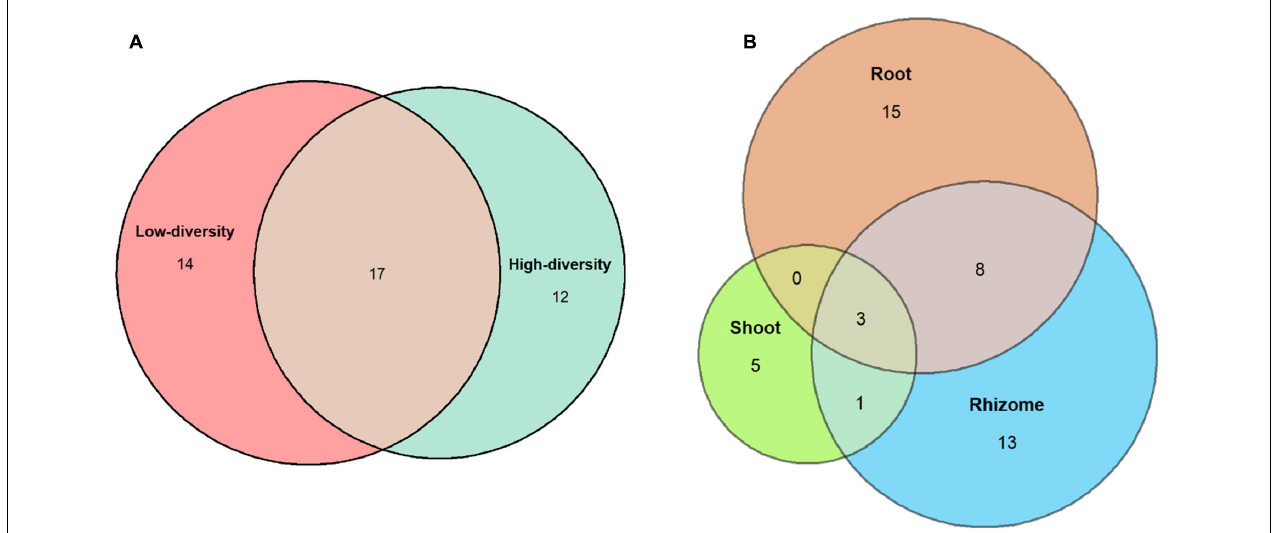
FIGURE 2 | Venn’s diagrams indicating the number of shared fungal species across grassland types (A) and tissues (B) .